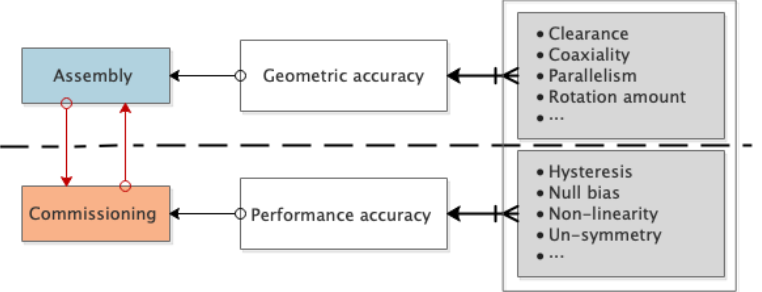
Figure 1. The connotation of the assembly-commissioning process.